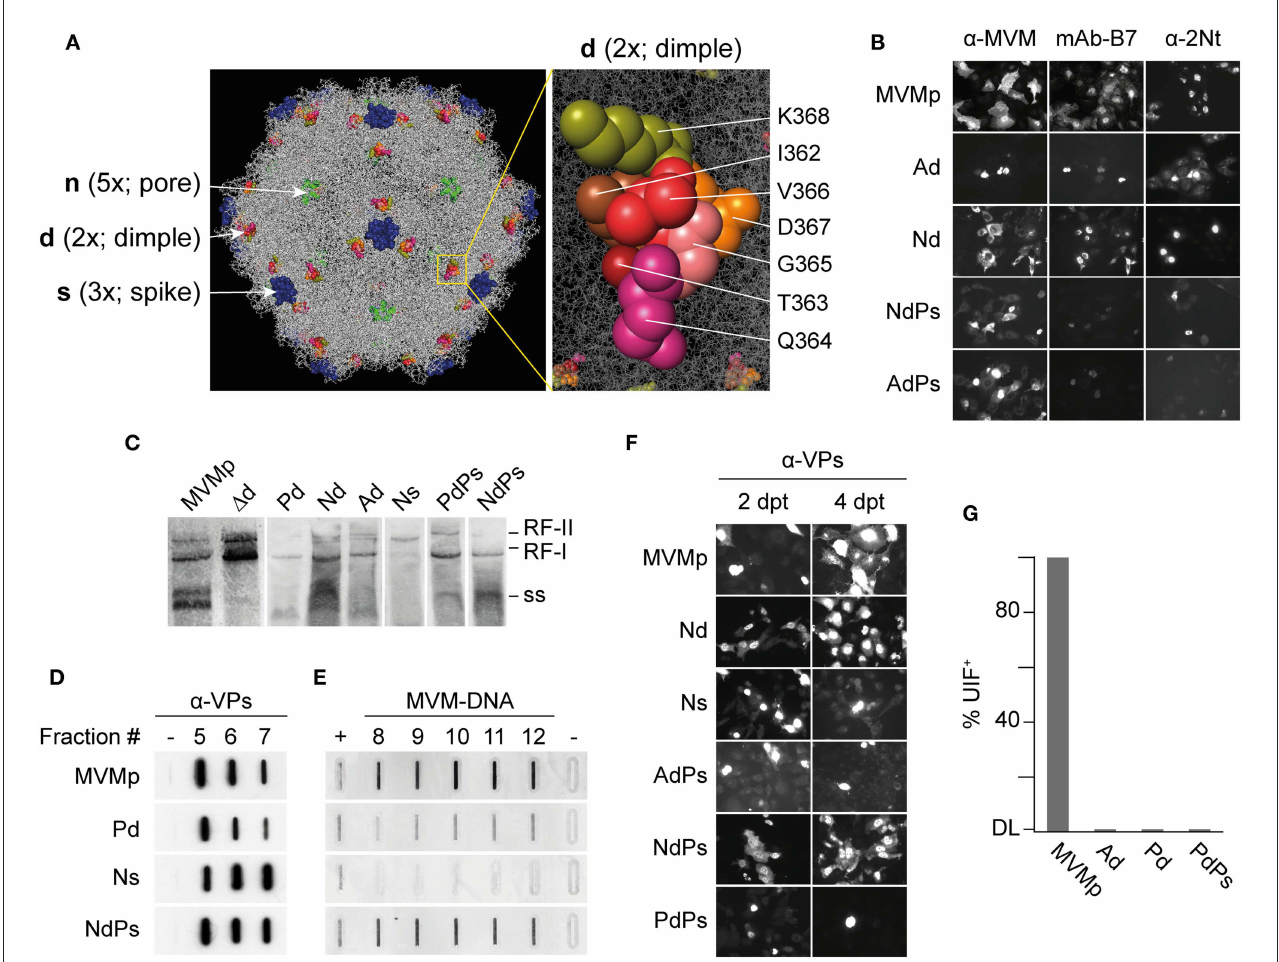
FIGURE1 Phenotypes of MVMp chimeras engineered with VEGF-blocking peptides at three capsid functional domains. (A) Left: Structure of the MVMp virus capsid (PDB 1Z14) highlighting the domains manipulated with VEbp at the dimple (2x), the spike (3x), and the VP2-N-terminus exposing through the pore (5x). Right: precise set of residues at the dimple (2x) replaced by VEbp. (B) IF staining with the antibodies shown above of cultures transfected by the indicated molecular clones (4 dpt). Representative fields are shown. (C) Genomic replication and ssDNA encapsidation capacity of chimeric viruses. Southern blot analysis of cultures transfected by the indicated molecular clones (2 dpt). The positions of the single-stranded DNA (ss) virus genome, and that of the monomeric (RF-I) and dimeric (RF-II) replicative forms, are indicated. (D, E) Slot-blot analysis of virus assembly performed in cellular samples at 2